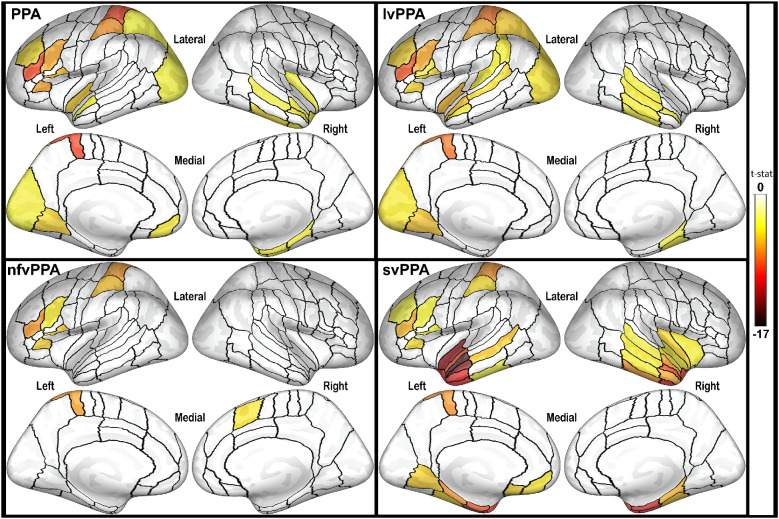

Atrophy patterns in PPA variants. Inflated cortical surfaces show ROIs with significantly thinner cortex compared to controls. The colour scale represents t-statistic of the effect, with false-discovery rate correction set at 0.001 for each comparison. PPA, primary progressive aphasia, all variants combined; lvPPA, logopenic variant primary progressive aphasia; nfvPPA, non-fluent variant primary progressive aphasia; svPPA, semantic variant primary progressive aphasia.